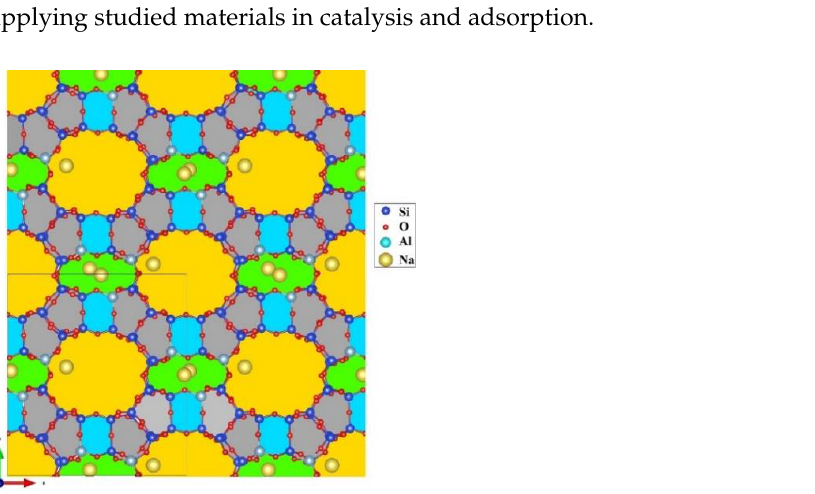
Figure 7. Distribution of different atomic species in the unit cell of NaMOR (enclosed in a square frame) for Si/Al = 7. In the image, the spaces enclosed by the 12-MR, 8-MR, 5-MR and 4-MR rings were colored yellow, green, gray and blue, respectively.